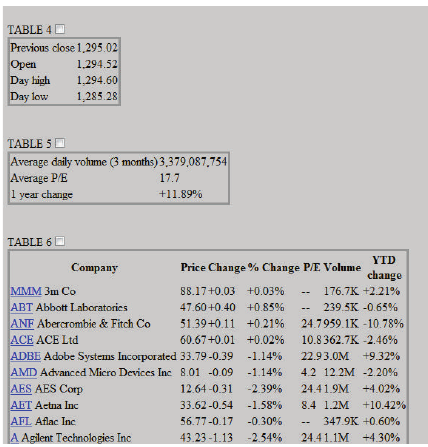
Figure 4: Screenshot of the list of retrieved